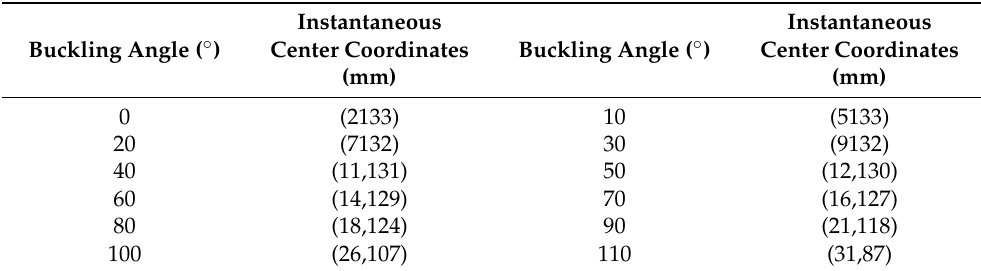
Table 1. Ideal instant center point coordinates.